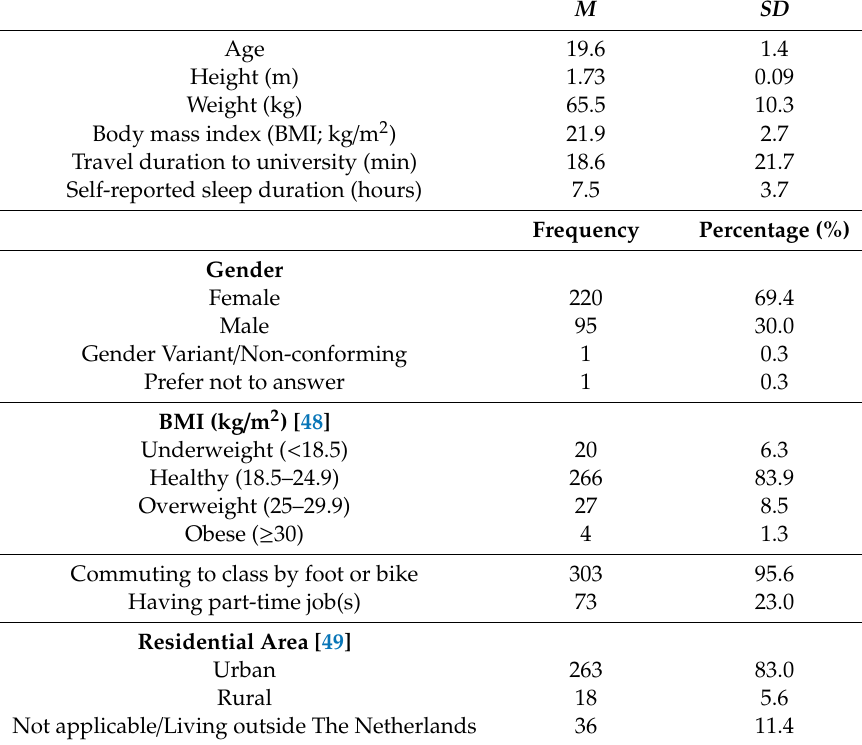
Table 1. Sample characteristics ( N =